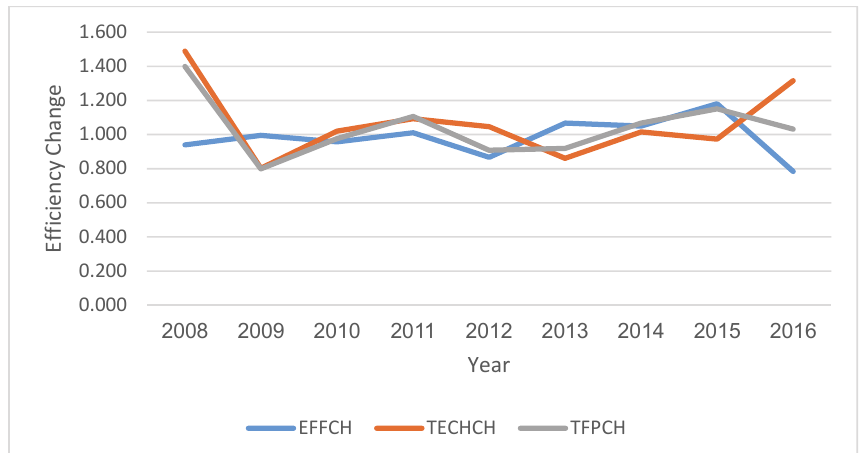
Fig. 1. Malmquist Index Summery of Annual